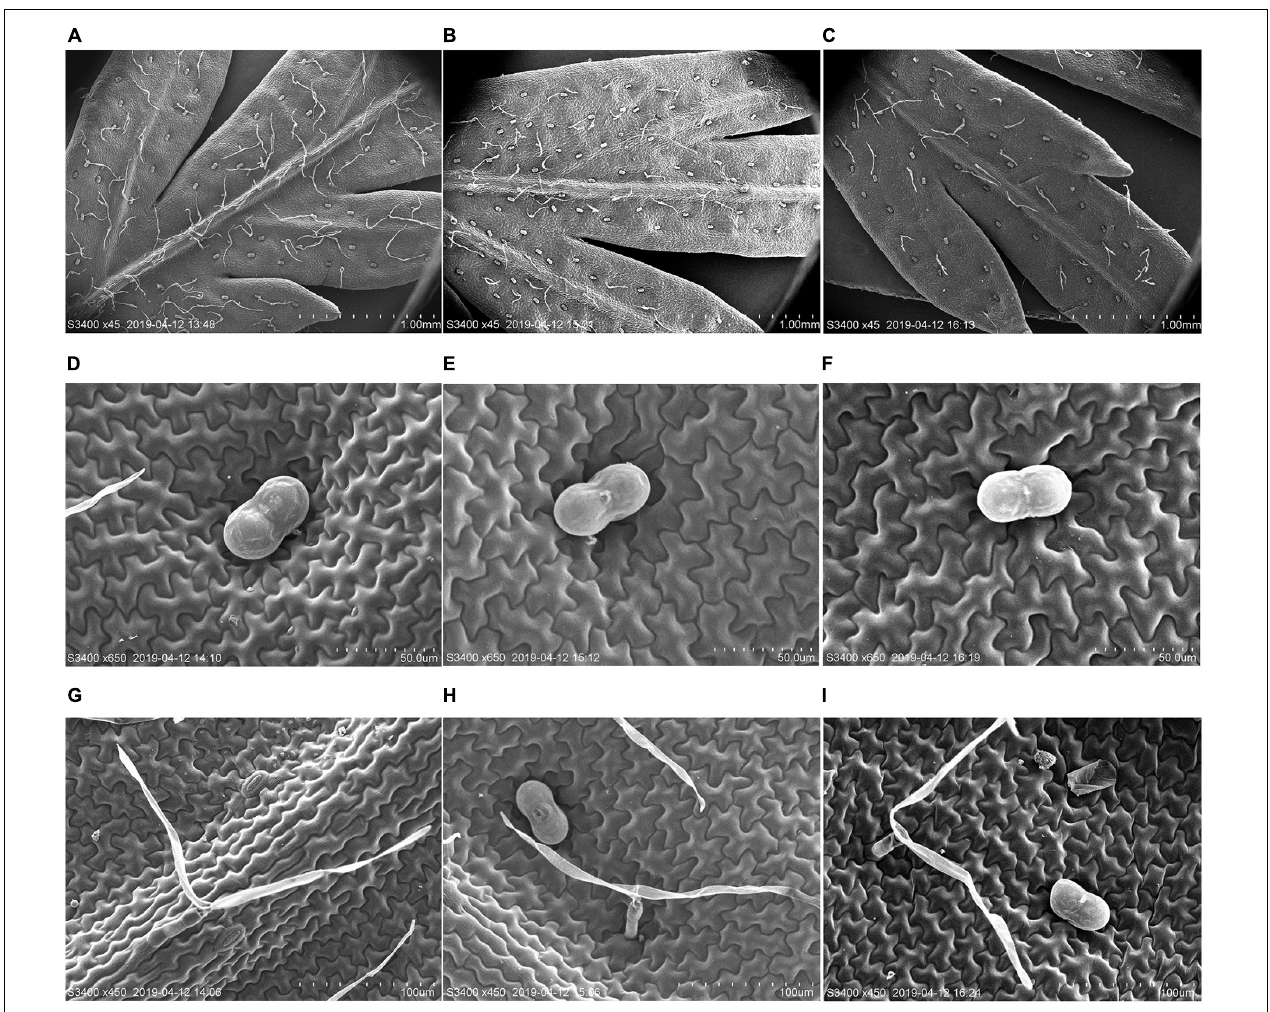
FIGURE 5 | Scanning electron microscope (SEM) analysis of the surface of leaves. (A) GSTs and T-shape trichomes (TSTs) on the adaxial sides of mature leaves derived from wild-type plants, (B) OE-AaMYB17 transgenic A. annua plants, and (C) AaMYB17-RNAi transgenic A. annua plants. (D) The morphologies of GST on the leaf of wild-type plants, (E) OE-AaMYB17 transgenic A. annua plants, and (F) AaMYB17-RNAi transgenic A. annua plants. (G) The morphologies of TST on the leaf of wild-type plants, (H) OE-AaMYB17 transgenic A. annua plants, and (I) AaMYB17-RNAi transgenic A. annua plants. Bars: (A–C) 1.00 mm; (D–F) 50 µ m; and (G–I) 100 µ